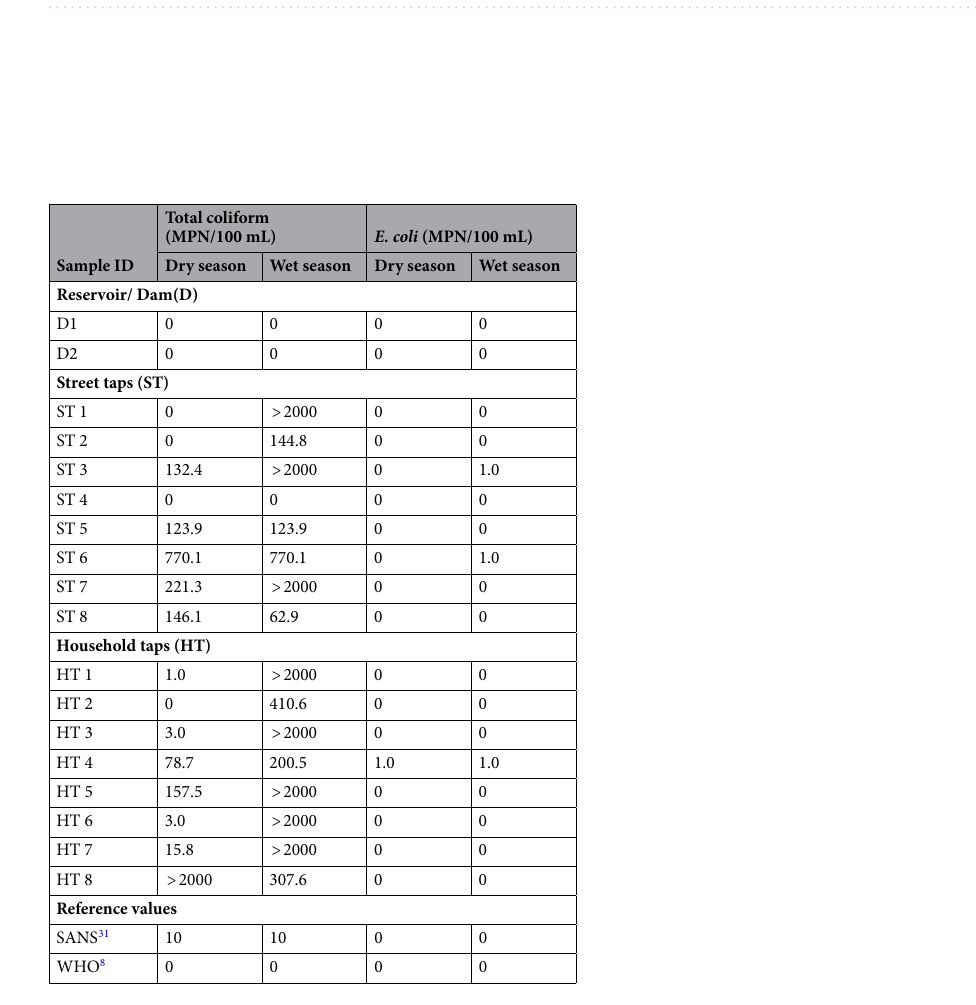
Table 4. Sanitation practices at the household level.